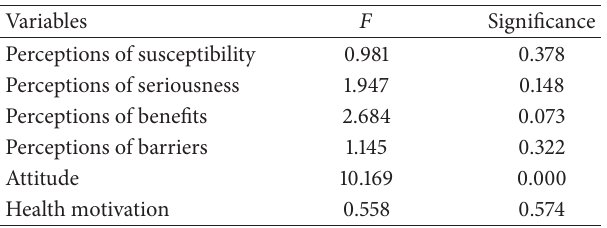
Table 5: ANOVA to examine differences in perceptions of health beliefs for women of different age